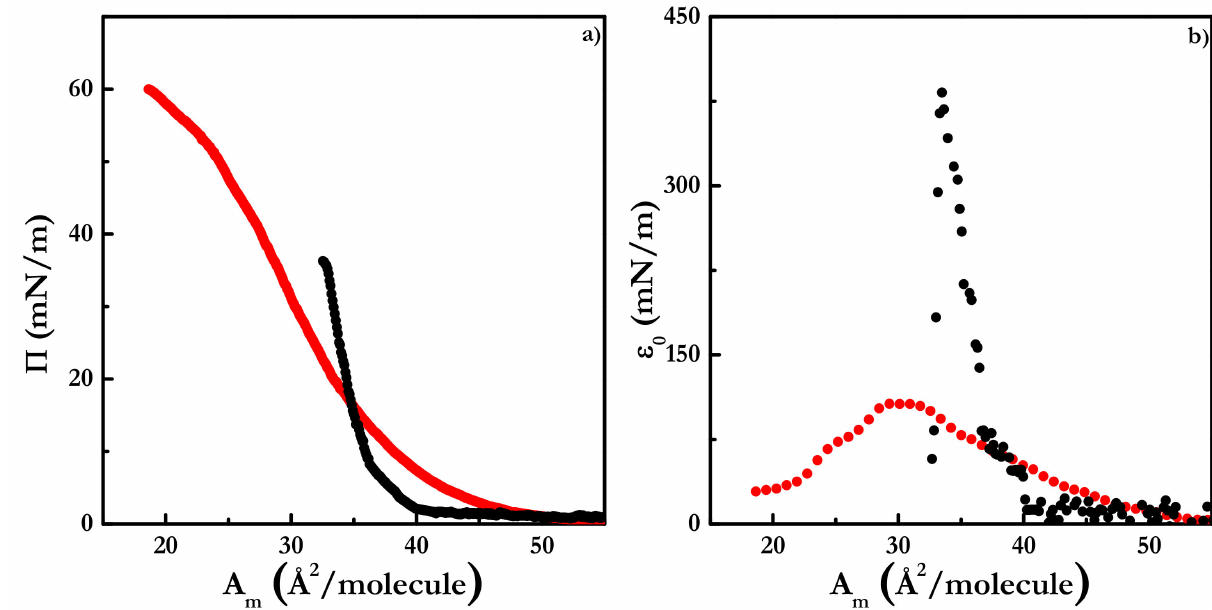
Figure 1. ( a ) Surface pressure-area per molecule of isotherms for Langmuir monolayers of CH and CE spread at the water/vapor interface at 24 ◦ C. ( b ) Quasi-static dilational elasticity, ε 0 , dependences on the surface pressure, Π , for Langmuir monolayers of CH and CE spread at the water/vapor interface at 24 ◦ C. In both panels: CH ( • ) and CS ( •